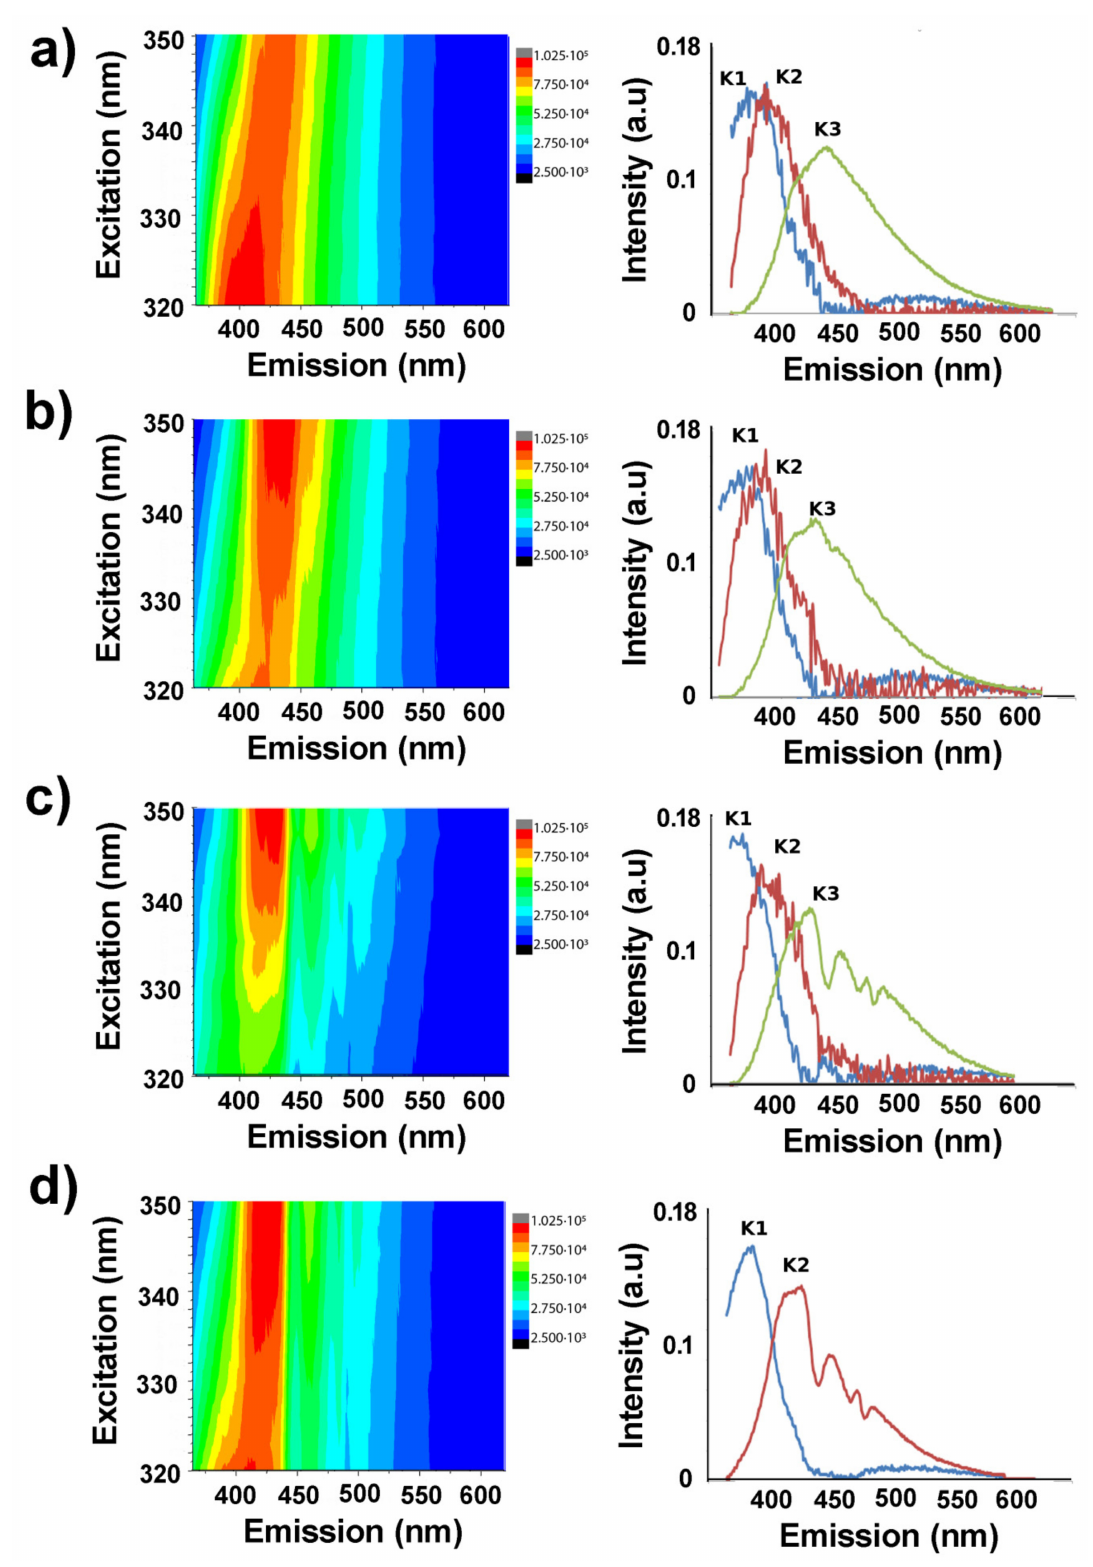
Figure 7. Excitation–emission maps ( left ), and emission components (K1, K2 and K3) obtained by applying the MCR–ALS method analysis ( right ) of FAP ( a ), Pr0.1CFAP ( b ), Pr0.5CFAP ( c ) and Pr1CFAP ( d )